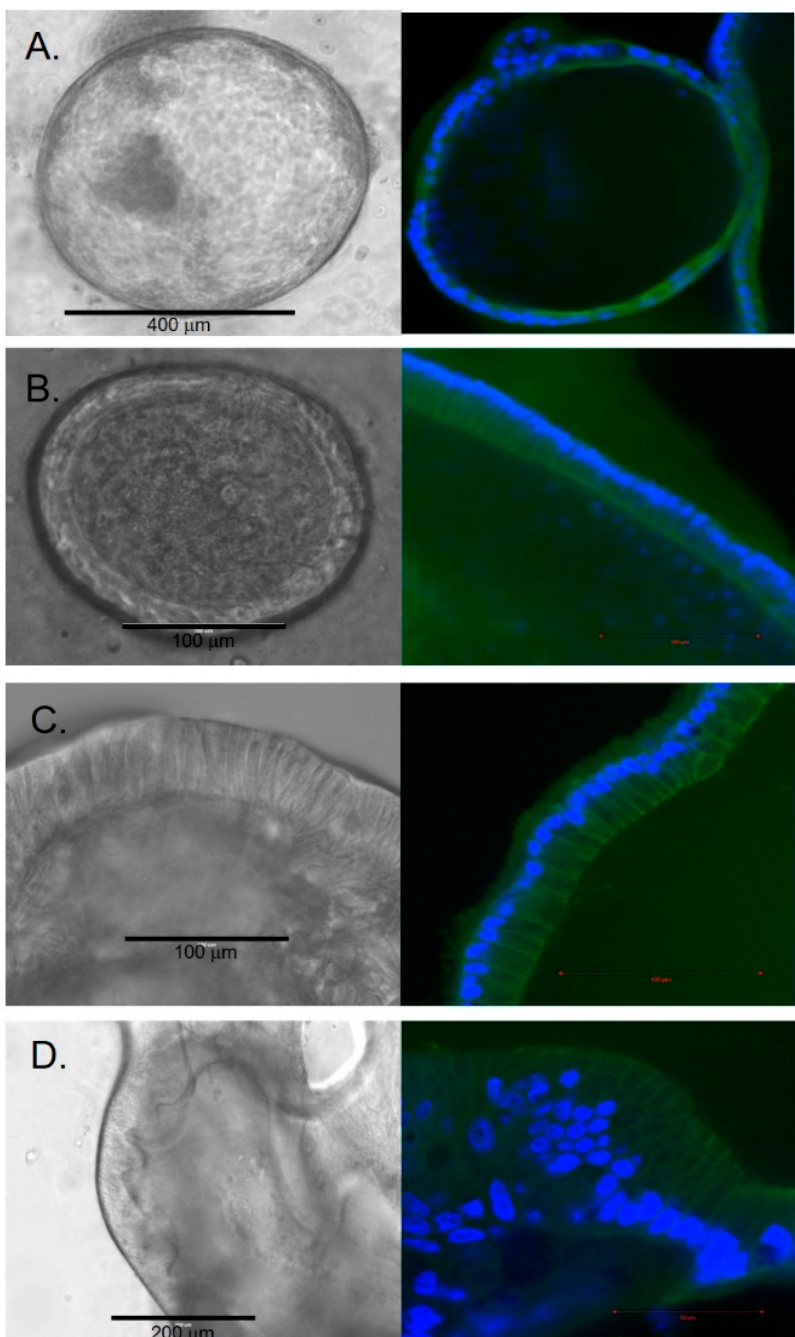
Figure 2. Cellular histology of chol-orgs with left column representing bright-field images and right column representing immunostaining with CK17 (green) and DAPI (blue) ( A ) Squamous epithelial morphology is present in early chol-orgs. Over time, cells develop a columnar epithelial morphology ( B , C ). In late organoids, multi-layered epithelial structures are observed ( D ). Over time, the majority of cultures contained structurally variable organoids ranging from simple, spherical organoids to organoids that were structurally more complex. To understand if the early-stage organoids transformed into late-stage organoids, we selected and tracked the early-stage organoids over time. We observed that some of the early organoids transformed into dense, irregular late-stage organoids (Figures 4 and